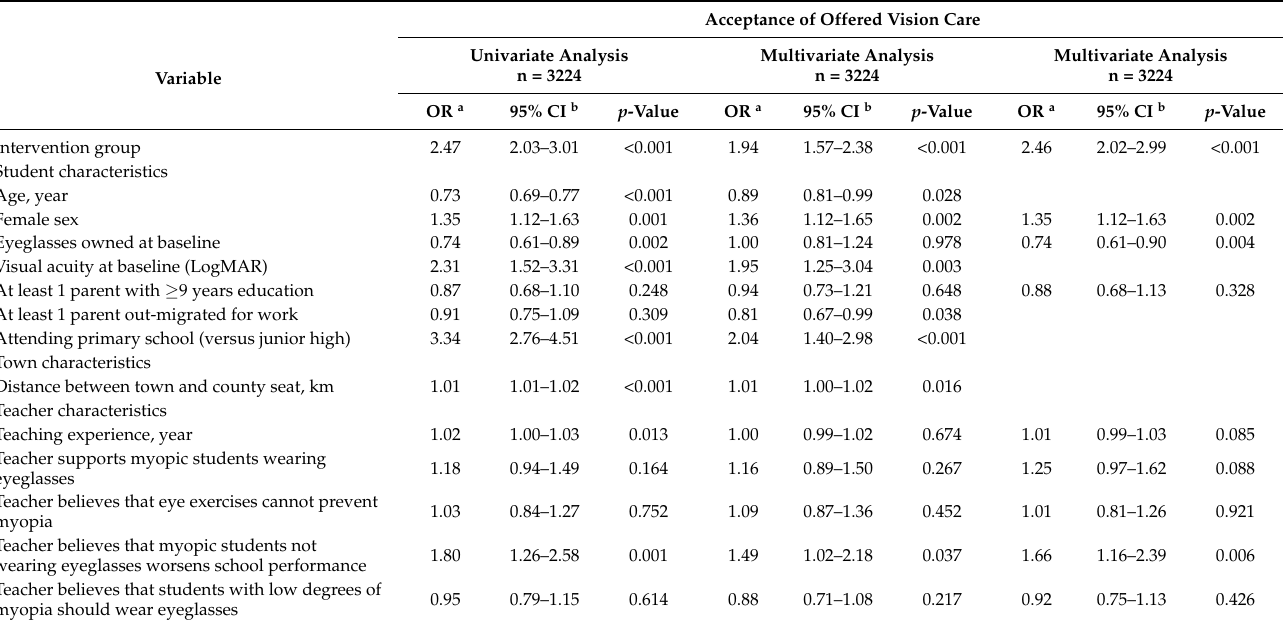
Table 3. Logistic regression analysis of the impact of providing teacher incentives on students’ acceptance of offered vision